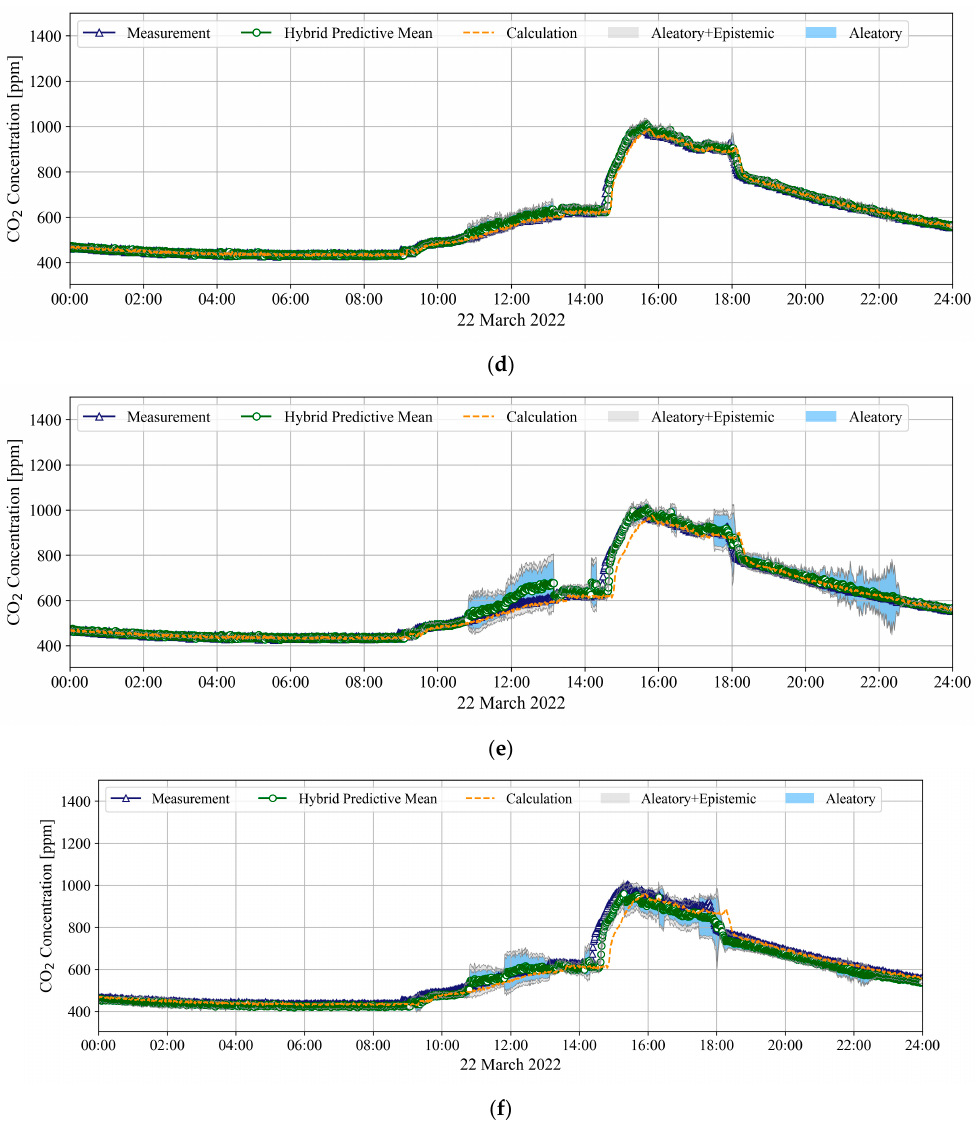
Figure 4. Time-series forecasting results obtained using the hybrid model and mass balance equation for the BR1 zone for the prediction horizons of ( a ) 5 min, ( b ) 10 min, and ( c ) 15 min for 21 March and ( d ) 5 min, ( e ) 10 min, and ( f ) 15 min for 22 March. Figures 5 and 6 display the scatter plots of the relationship between the measurement and forecasting results obtained using the hybrid model and mass balance equation for the LR and BR1 zones. In particular, the results obtained using the hybrid model can be represented as the predictive mean and upper and lower boundaries of the total uncertainty, which includes the aleatoric and epistemic uncertainties. In the scatter plots, the relationships between the measurements and results obtained from each model are represented by a line plotted using first-order linear regression. The relationship between the measurement and forecasting results obtained from the mass balance equation shows that the variance gradually increases as the prediction